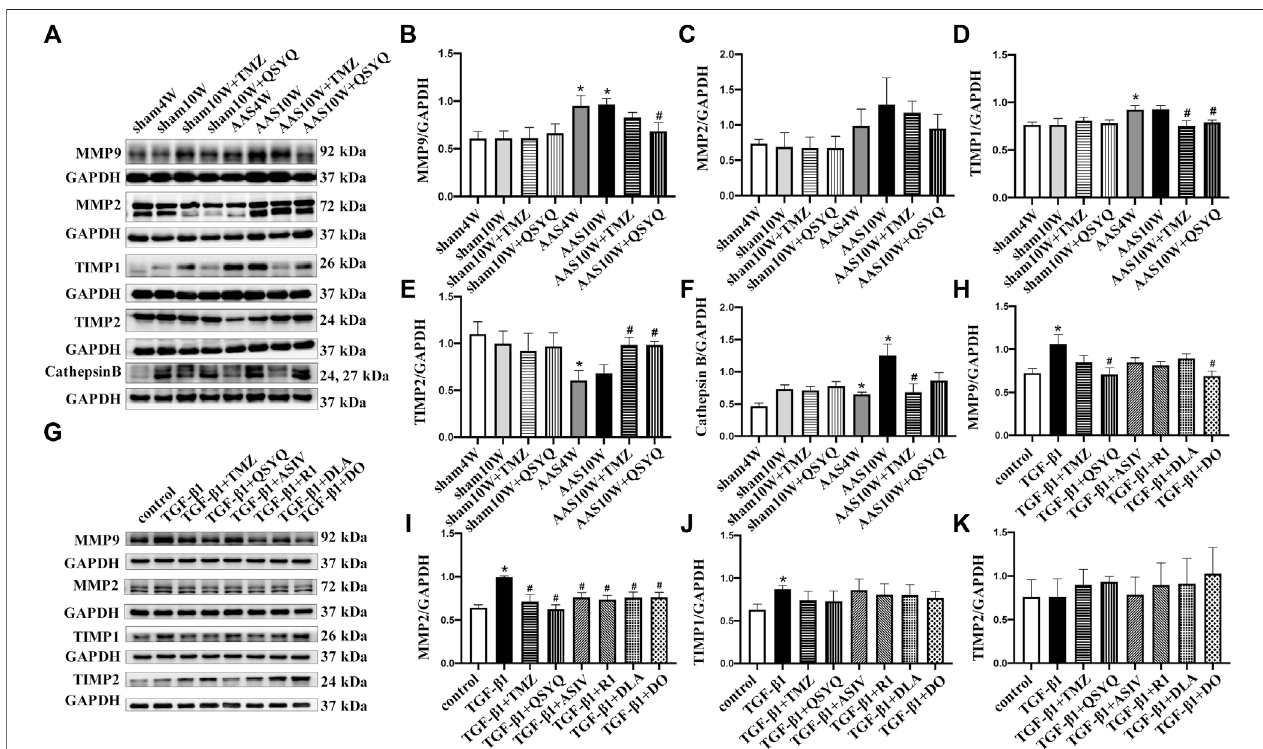
FIGURE 6 | QSYQ regulated abnormal expression of MMP/TIMP. (A) Expression of MMP2, MMP9, TIMP1, TIMP2, and cathepsin B in rat myocardium examined by Western blotting. (B – F) Quanti fi cation of Western blot results of MMP2, MMP9, TIMP1, TIMP2, and cathepsin (B) . (G) Expression of MMP2, MMP9, TIMP1, and TIMP2 in RDF cells examined by Western blot. (H – K) Quanti fi cation of Western blot results for MMP2, MMP9, TIMP1, and TIMP2. Data are presented as the mean ± SEM, n = 4. * p < 0.05 vs. sham or control; # p < 0.05 vs. AAS or TGF- β